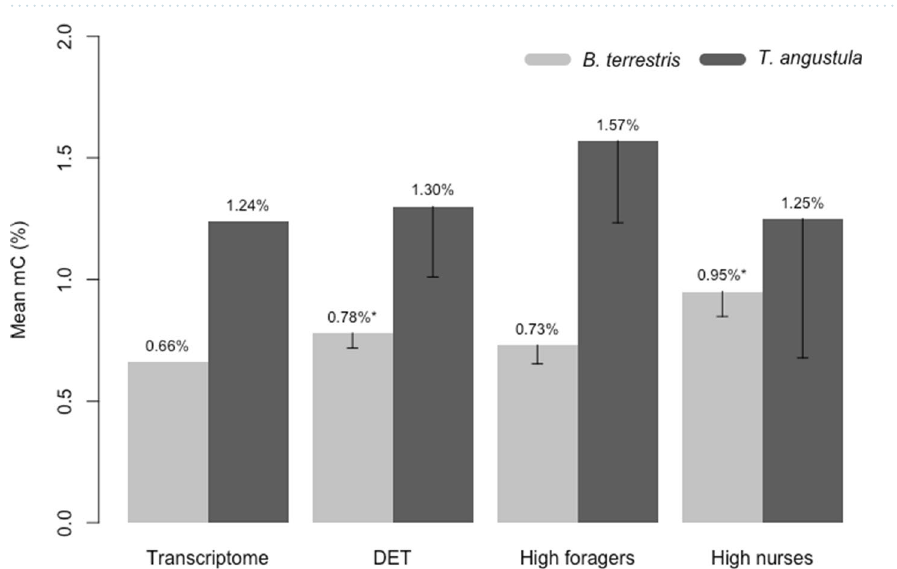
Figure 3. Mean mC levels in distinct gene sets of B. terrestris and T. angustula nurses. Transcriptome—refers to the values observed in the complete transcriptome; DET—differentially expressed superTranscripts between nurses and foragers; High foragers—superTranscripts with higher expression levels in foragers when compared to nurses; High nurses—superTranscripts with higher expression levels in nurses when compared to foragers. * Significantly different from the global transcriptomic mean, with p < 0.01 at 95% CI; confidence interval bars of the statistical tests of significance are